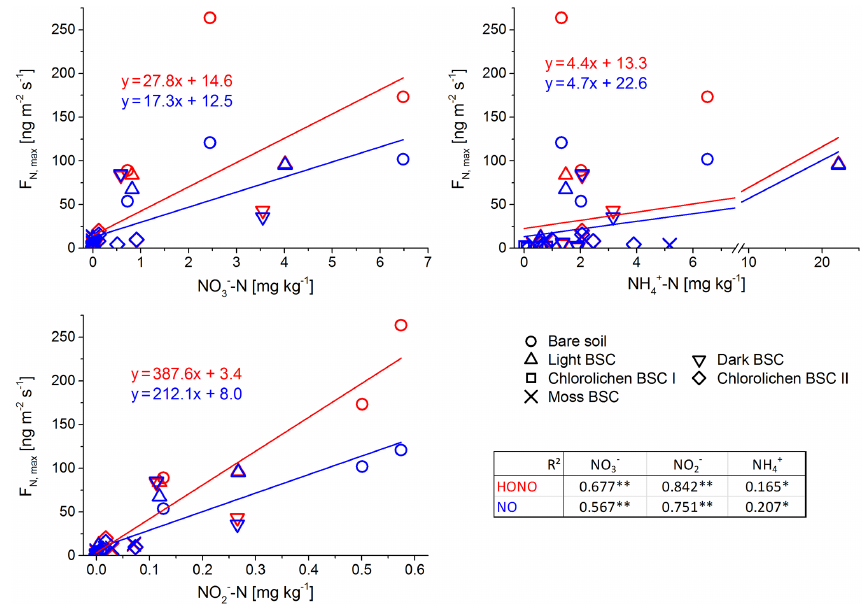
Figure 6. Correlation between maximum flux of HONO and NO and nutrient content of all Cyprus soil and biocrust samples with Pearson correlation factors (of log-transformed data; **: p <0.001; *: p